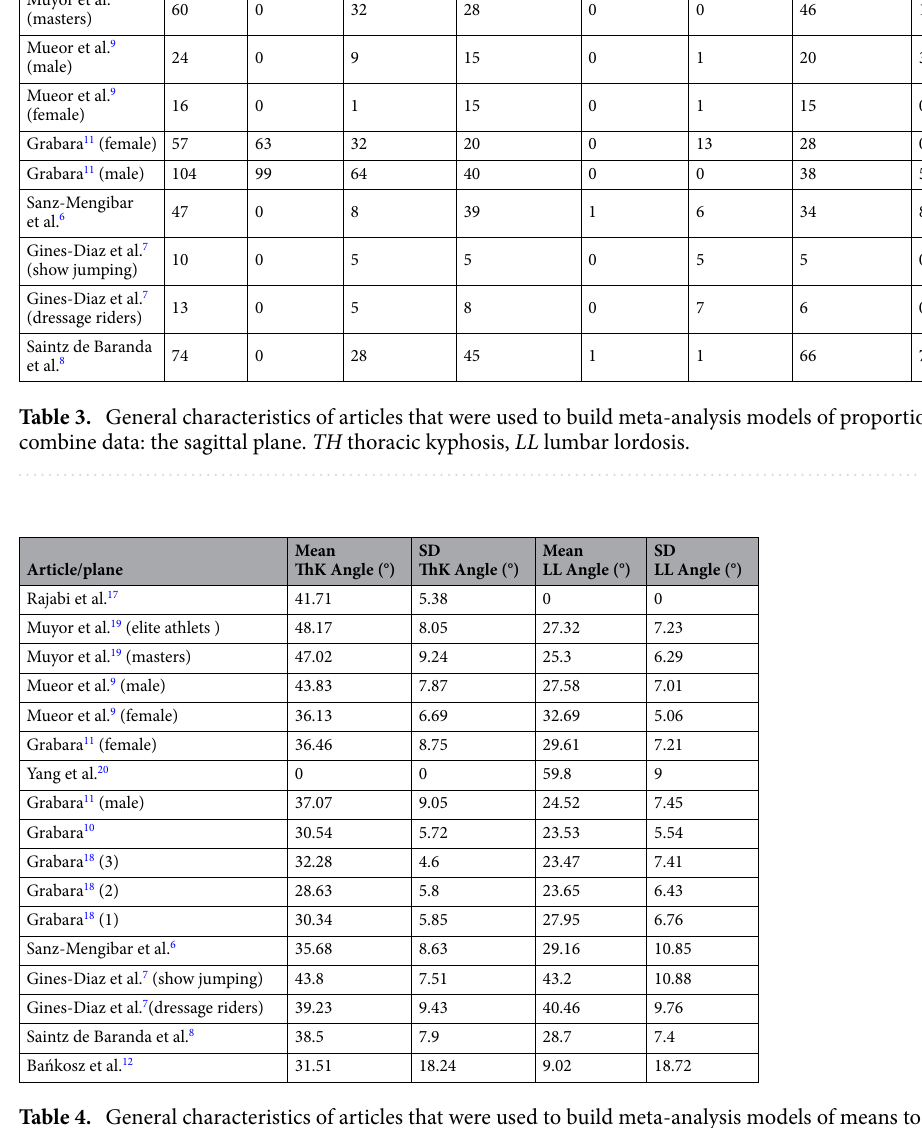
Table 4. General characteristics of articles that were used to build meta-analysis models of means to combine data: the sagittal plane. ThK thoracic kyphosis angle, LL lumbar lordosis.